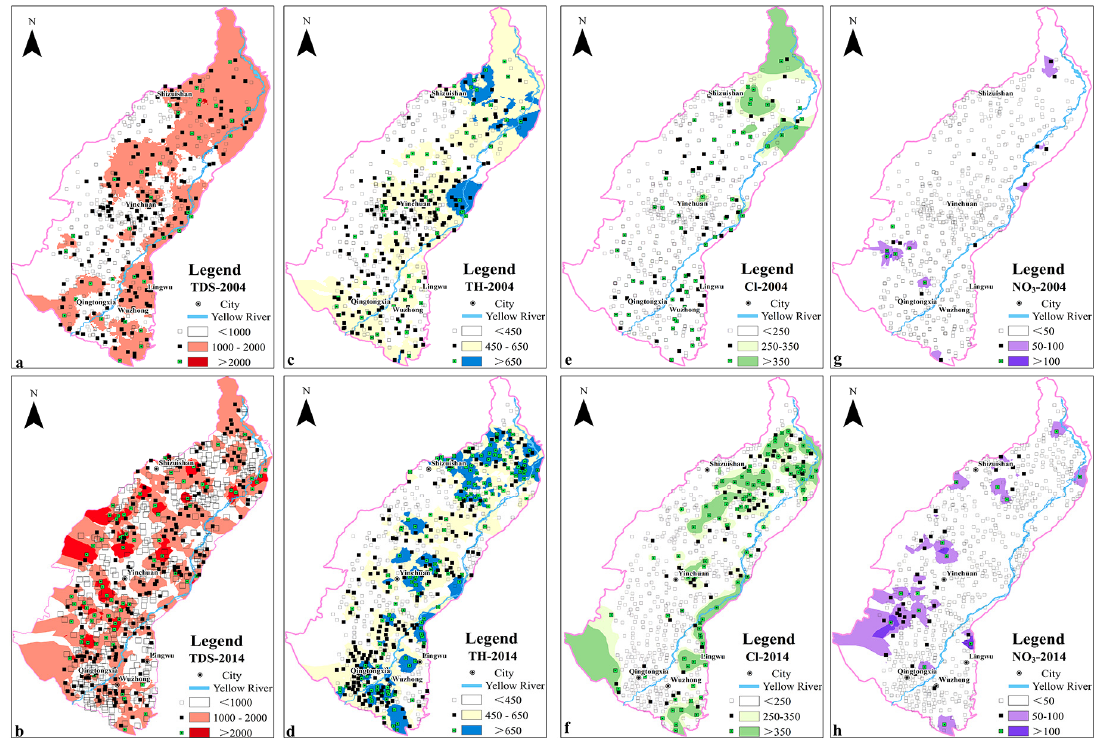
Figure 8. Spatial distribution of some typical pollutants: total dissolved solids (TDS) in ( a ) 2004 and ( b ) 2014, total hardness (TH) in ( c ) 2004 and ( d ) 2014, Cl (cid:2879) concentration in ( e ) 2004 and ( f ) 2014, and NO (cid:2871)(cid:2879) concentration in ( g ) 2004 and ( h ) 2014.